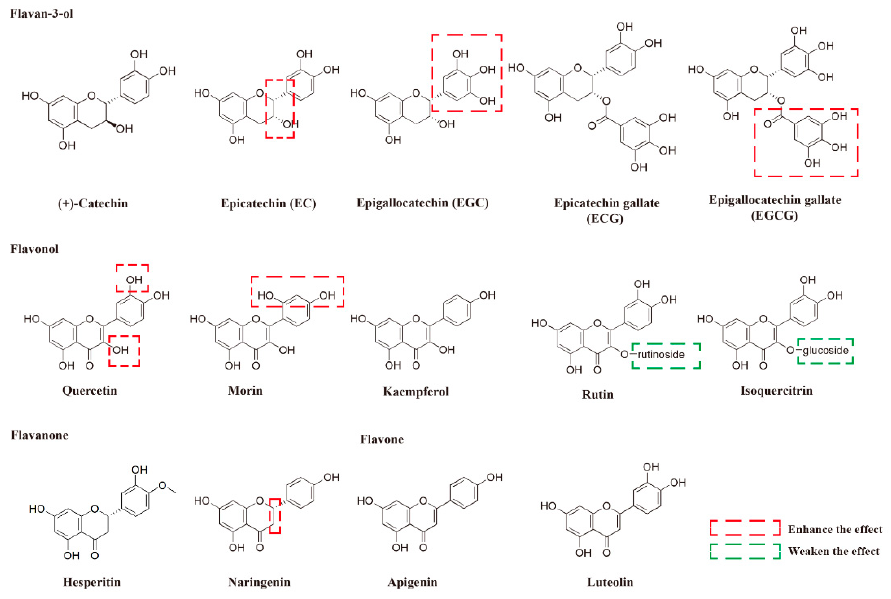
Figure 1. The main flavonoids tested in protective activities against MG-induced PC-12 cells. Table 1. The protection activities and molecular-docking data of main flavonoids.